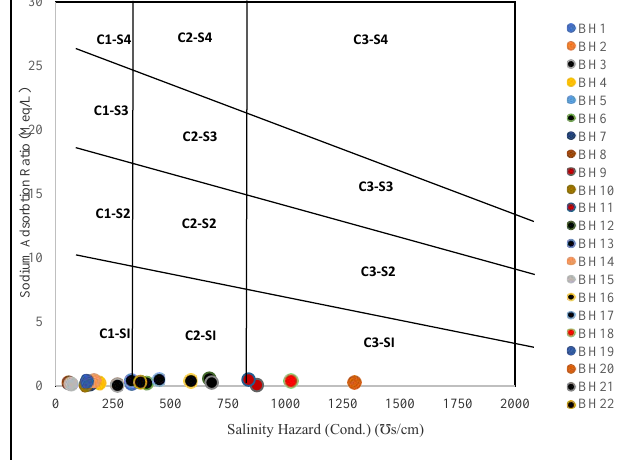
Figure 2: Classification of groundwater with respect to SAR and salinity hazard